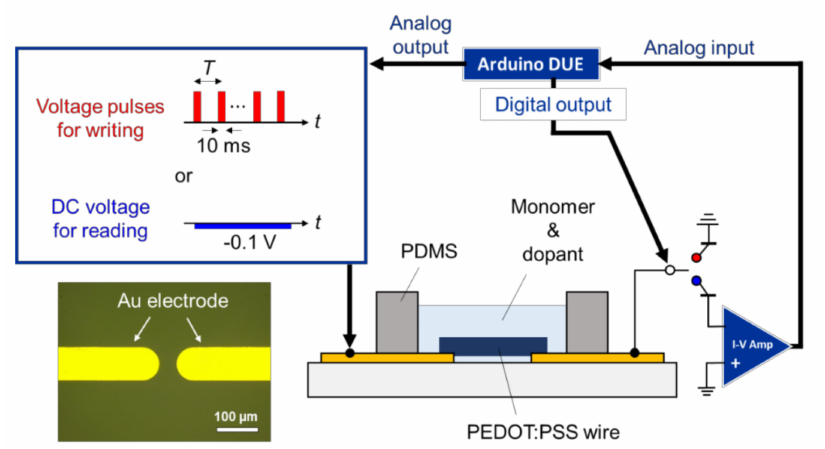
Figure 2. Schematic diagram of the experimental setup with a corresponding optical microscope image of the Au electrode gap. During conductance writing, the microcomputer supplied continuous voltage pulses and the counter electrode was switched to ground (GND). During conductance reading, the microcomputer supplied a − 0.1 V DC voltage and the counter electrode was switched to the I–V